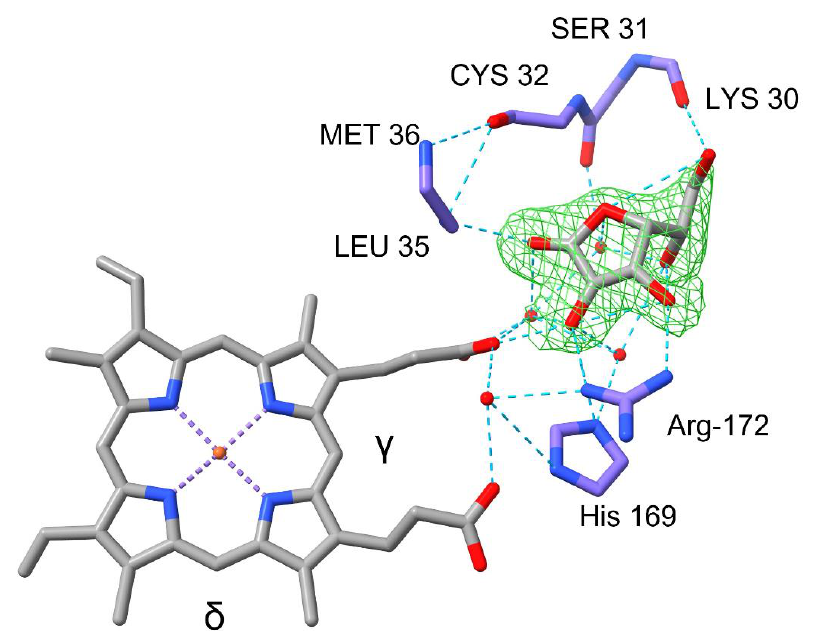
Figure 4. Ascorbate complex structure of PviAPX. The ascorbate molecule was shown in gray at γ -edge. This pocket was surrounded by Cys-32, Pro-34, His-169 and Arg-172. Nitrogen is shown in blue, oxygen in red and purple indicates carbon of residues. Purple dashed lines indicate metal coordination and blue dashed line indicate hydrogen bond network. This figure was produced using the Chimera package (UCSF, NIH P41 RR-01081).